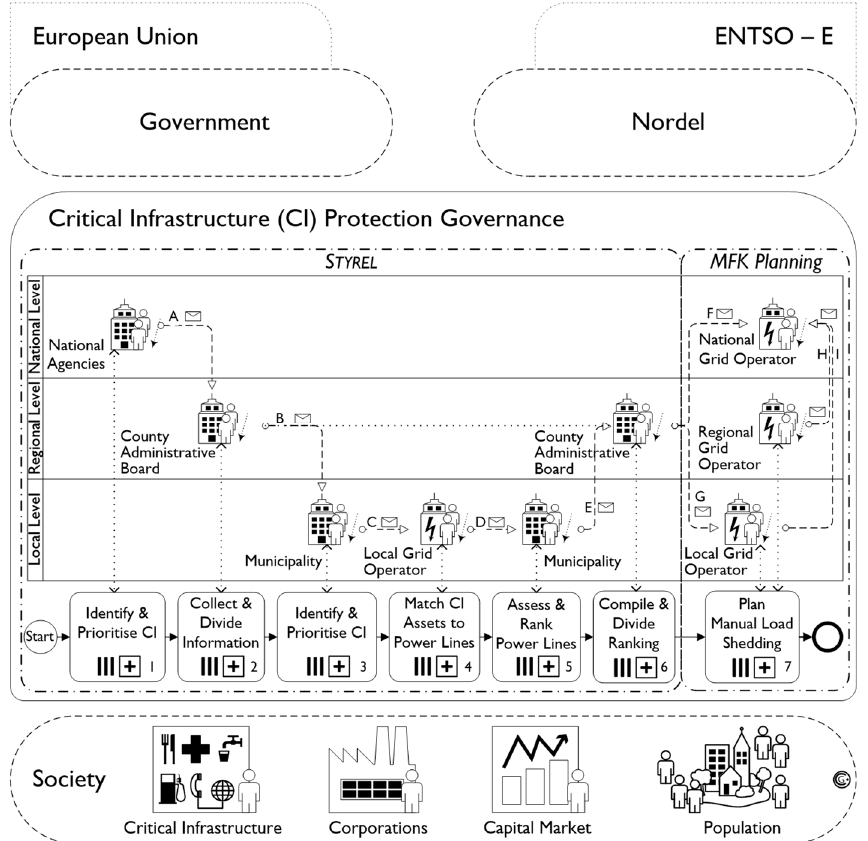
Figure 1. The reference process of S TYREL (MFK is the Swedish acronym for manual load shedding: manuell förbrukningsfrånkoppling).